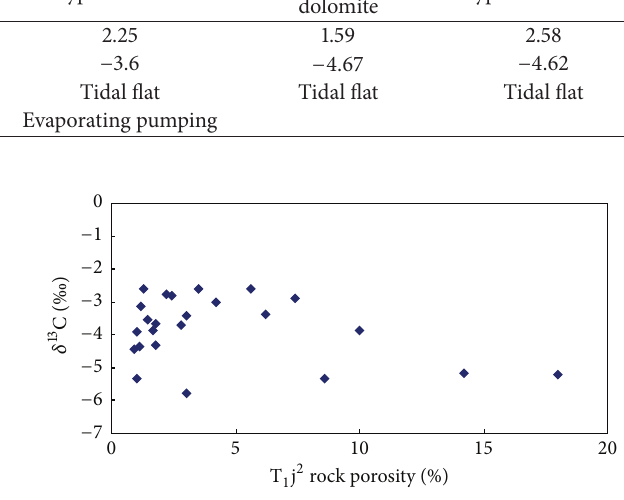
Figure 10: The distribution of oxygen and carbon isotope.